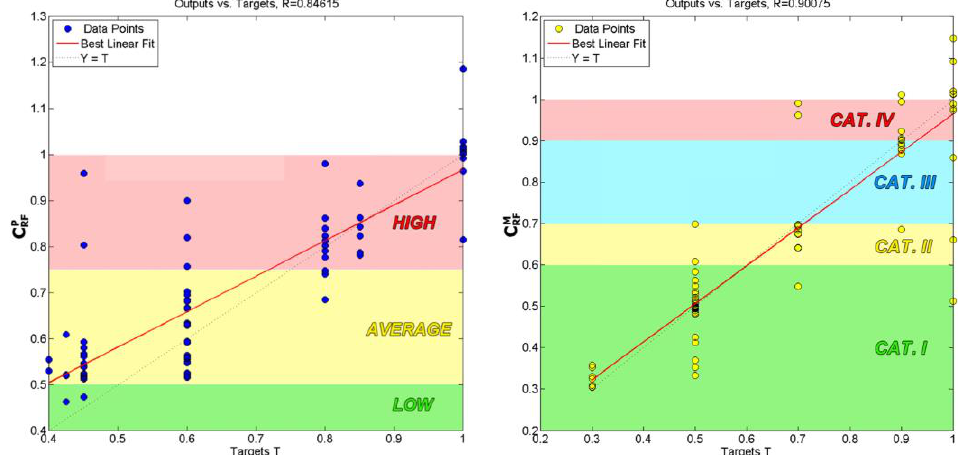
Figure 19. Evaluation of rock mass propensity to failure based on developed roof fall hazard index ( left ) and evaluation of roof stability — categories of roof fall hazard ( right ) [24].